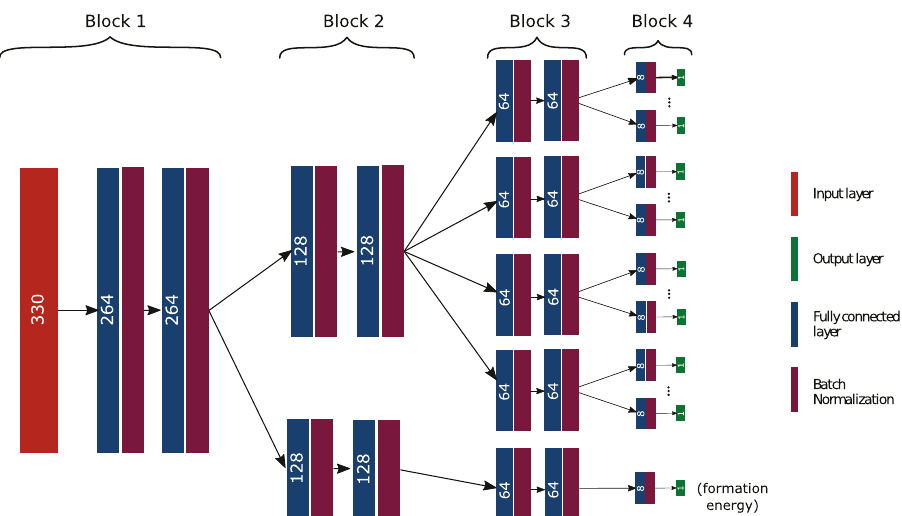
Fig. 6 MODNet architecture for the vibrational properties. The architecture of the MODNet (composed of four blocks) when learning on the vibrational properties. The formation energy is added by adding a second-order block to the fi rst